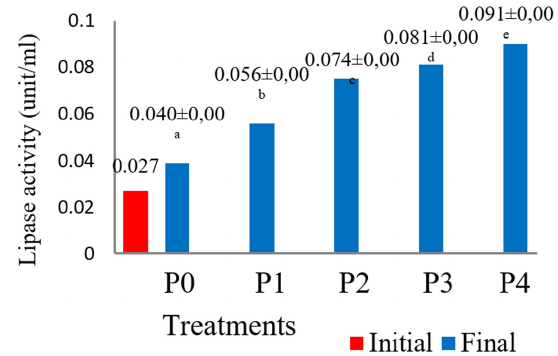
Figure 2. Changes in lipase enzyme activity in the intestine of silver pompano. P0 = FFM 0%, P1 = FFM 10%, P2 = FFM 20%, P3 = FFM 30%, and P4 = FFM 40%.